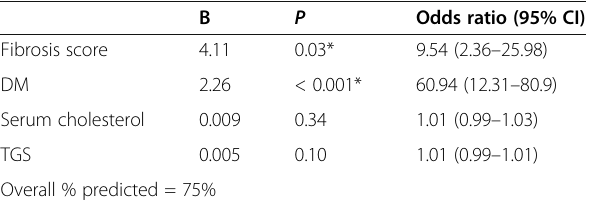
Table 8 Predictors of H. pylori infection in cases of MET S